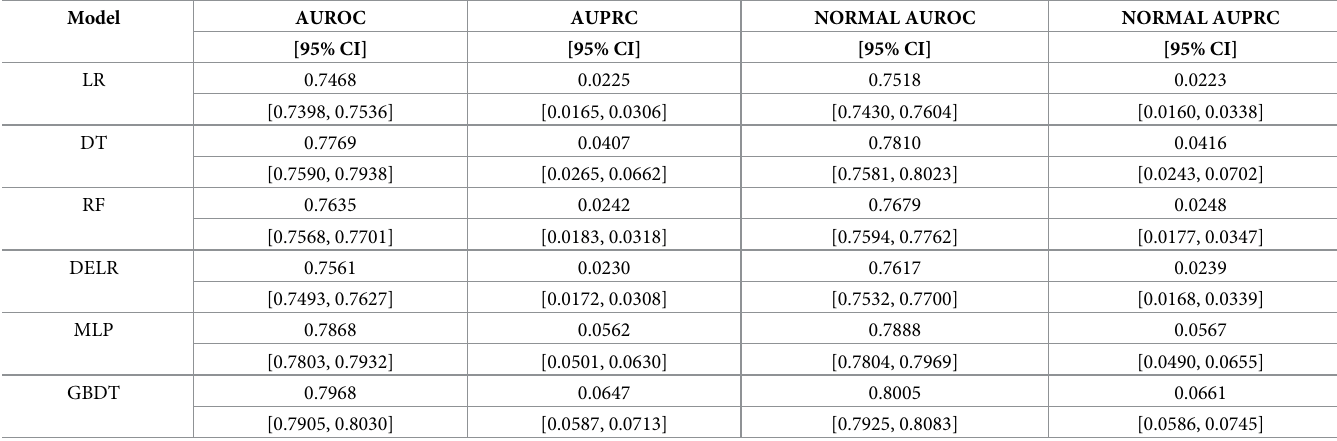
Table 2. Model performance using the test data set ( N = 1160839).